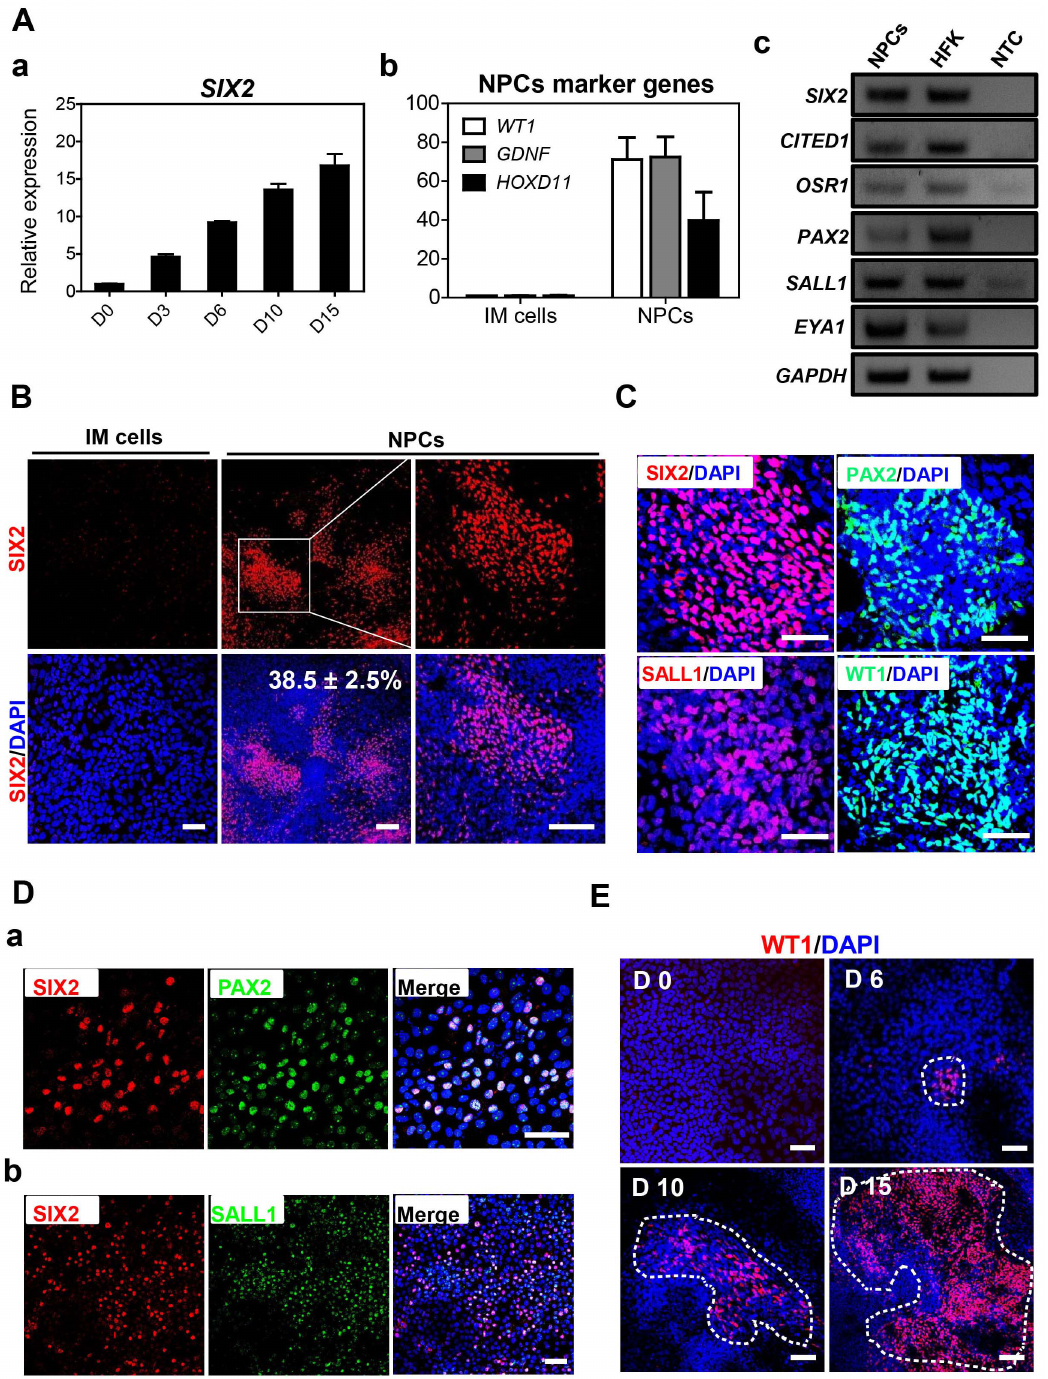
Figure 4. Differentiation of hESC-derived IM cells into NPCs. A. (a) Time course of the transcriptional expression of key NPCs marker SIX2 in hESC-derived NPCs. Appropriate duration of NPCs induction was determined by relatively higher transcriptional expression of SIX2 than other days. Transcription of other NPCs marker genes were examined by (b) real time RT-PCR and (c) RT-PCR in hESC-derived NPCs. Human fetal kidney (HFK) cDNA was used as positive control. Relative transcriptional levels were normalized to GAPDH, and the bars show mean 6 S.E.M (n=3). B. SIX2 expression rate was compared between hESC-derived IM cells and NPCs. Quantification of the number of cells expressing the key markers of specific differentiation stage was performed by manual counting in three randomly chosen fields. Scale bars=200 m m. C. Several NPCs markers, including SIX2 (red), PAX2 (green), SALL1 (red) and WT1 (green) were notably detected in hESC-derived NPCs. Scale bars=100 m m. D. Co-expression of other NPCs markers such as PAX2 (green) and SALL1 (green) with SIX2 (red) in hESC-derived NPCs in immunofluorescence. Scale bars=100 m m. E. Immunocytochemistry for WT1 expression during NPCs induction in hESC-derivatives. WT1 expression (red) was evaluated at four different time points of NPCs induction (D0, D6, D10 and D15 of NPCs induction after IM stage). WT1-positive regions are designated by white lines. Scale bars=100 m m.